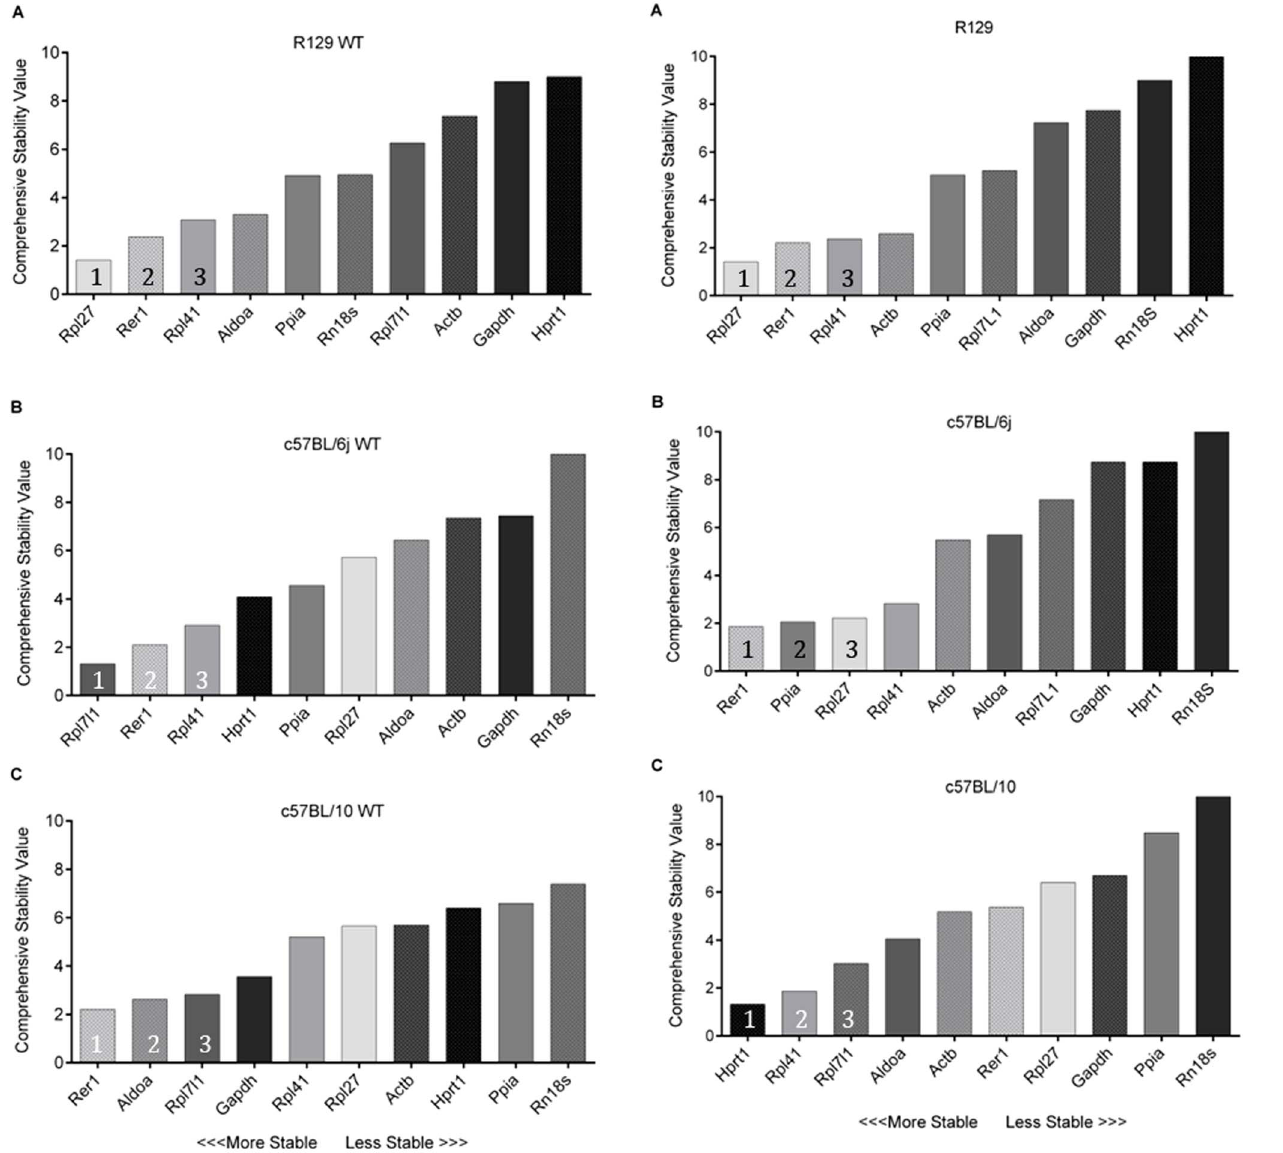
Figure 2. RefFinder analysis comparing the selected reference genes for WT quadriceps muscle expression. A) R129 WT, B) C57BL/6j WT, C) C57BL/10 WT. Columns are shaded (light to dark) based on R129 WT gene stability order to represent the shift in gene position between C57BL/6j and C57BL/10 strains. 1 – 3 represent the top three genes in each analysis.